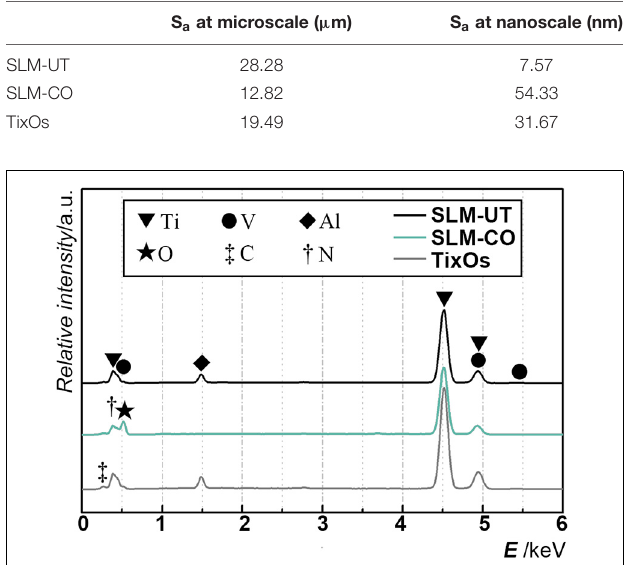
Figure 5D illustrated the photograph of alizarin red